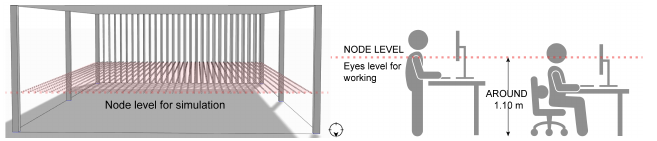
Figure 10. Set-up of the model for simulation in terms of daylight